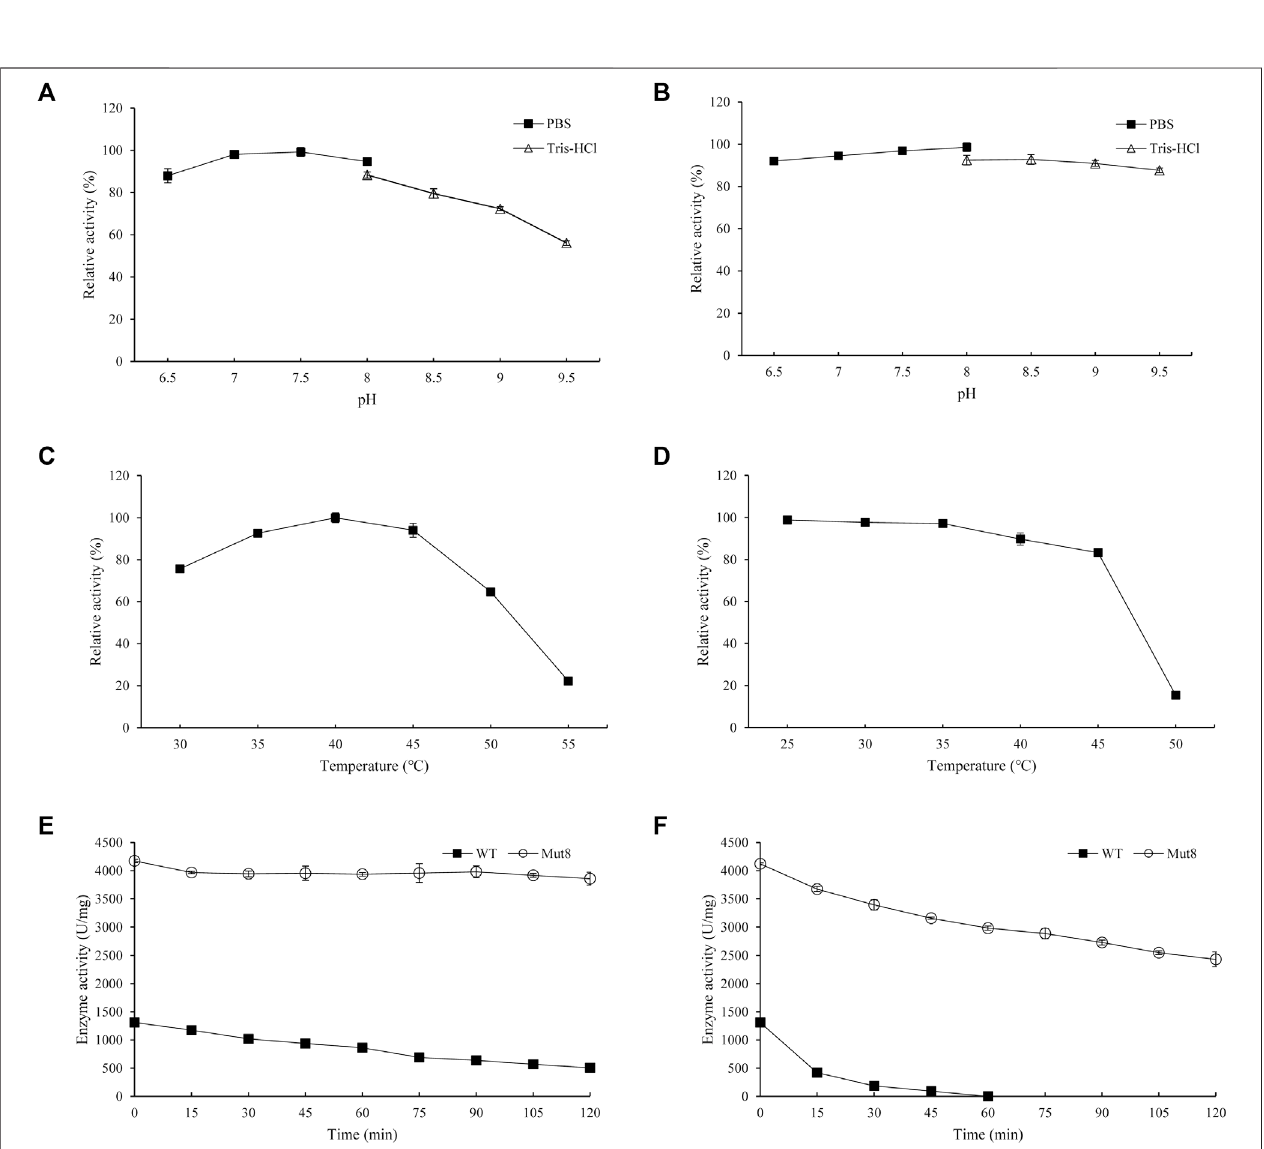
FIGURE 6 | (A) Optimal pH of Mut8; (B) pH stability of Mut8; (C) optimal temperature of Mut8; (D) thermal stability of Mut8; (E) thermostability of WT and Mut8 incubated at 35 ° C; (F) thermostability of WT and Mut8 incubated at 40 ° C. Error bars represent standard deviations, and three replicates were